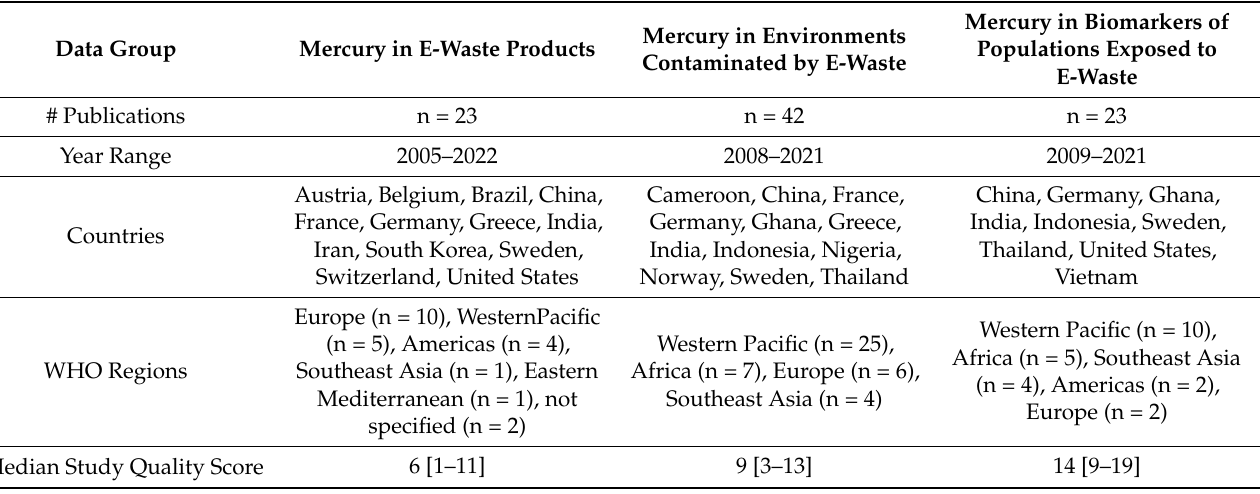
Table 2. Studies Included in Data Groups of